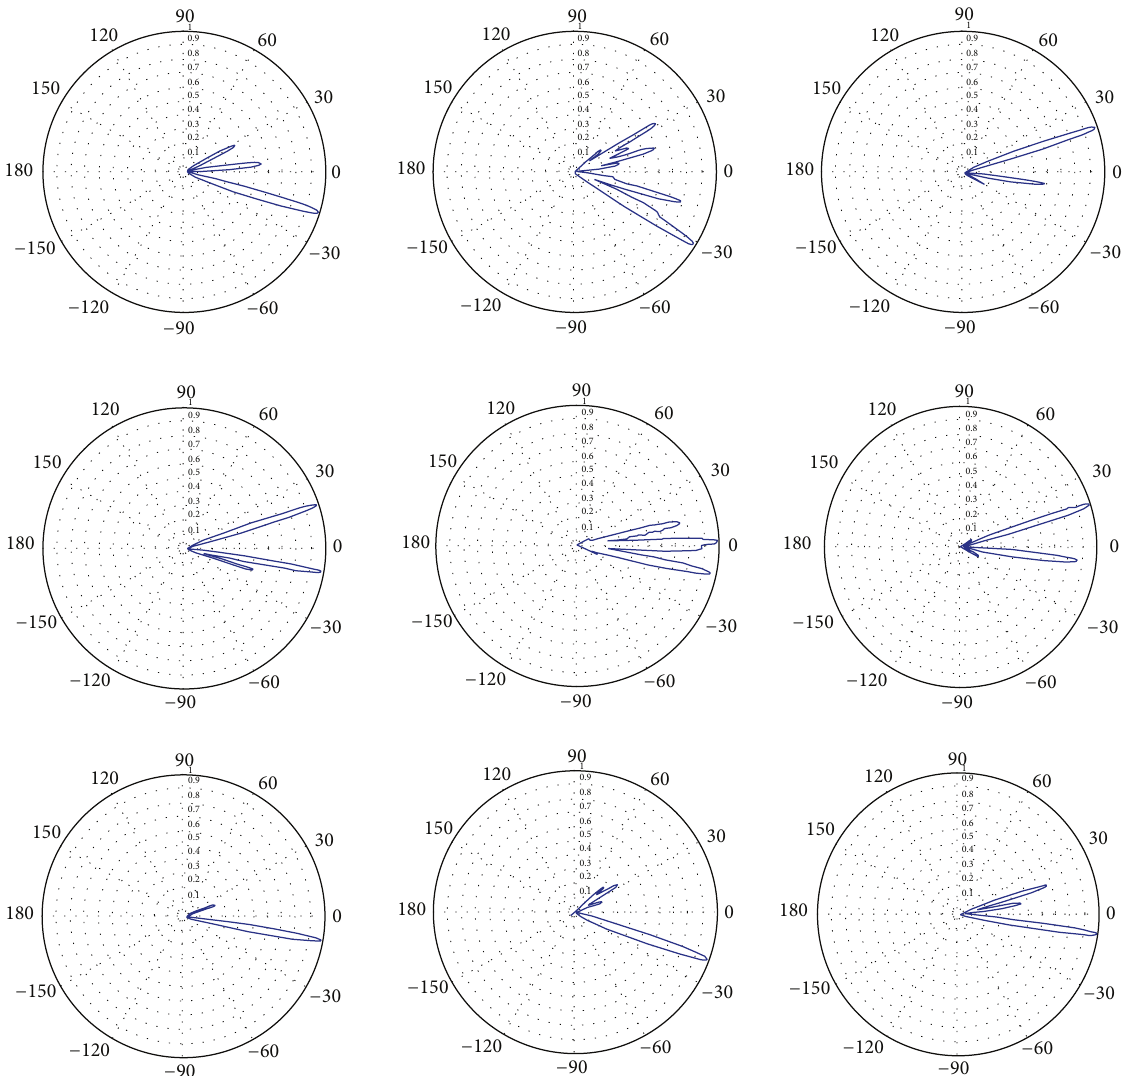
Figure 14: Distribution of angular range and amplitude for CTPCs according to their